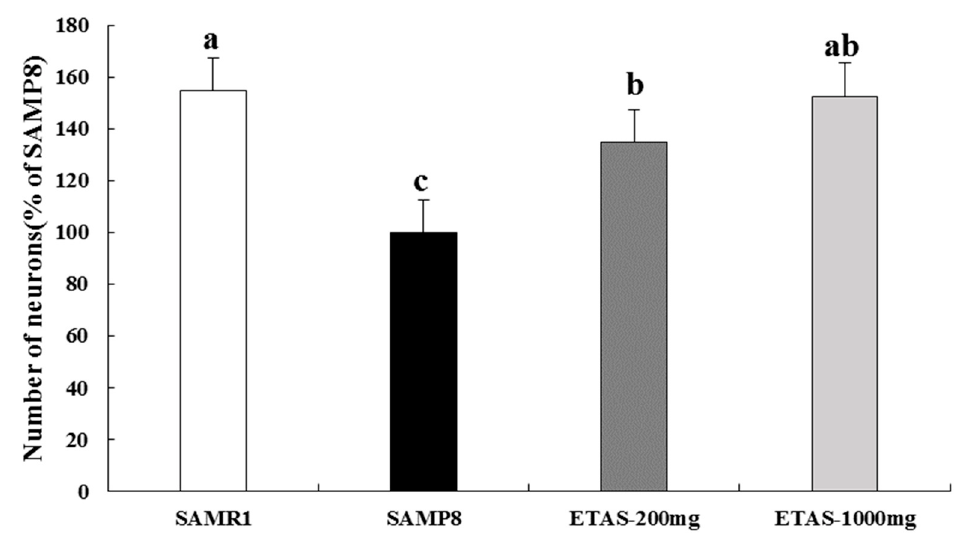
Figure 6. Neuron numbers in the suprachiasmatic nuclei of 3-month-old male mice fed with a different diet for 12 weeks. Neuron numbers of Nissl staining was assessed under 10× magnification. The y axis denotes the percentage of each group compared to the SAMP8 control group. Values were mean ± S.E.M. (n = 8/group). Data with different superscripts are significantly different among groups.